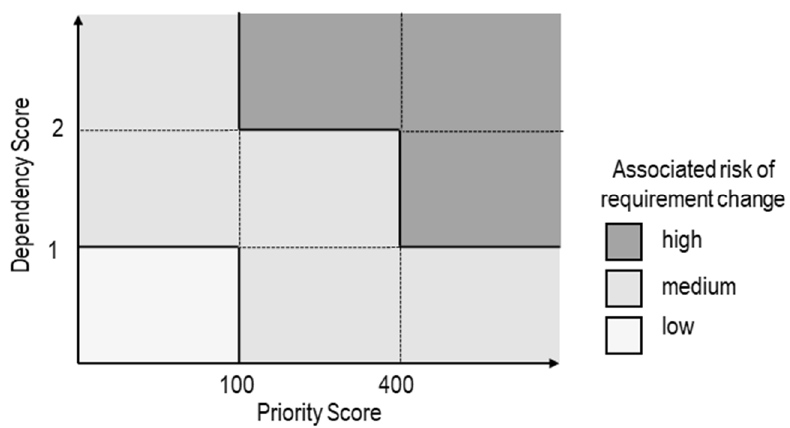
Figure 9. Risk of requirement change portfolio.